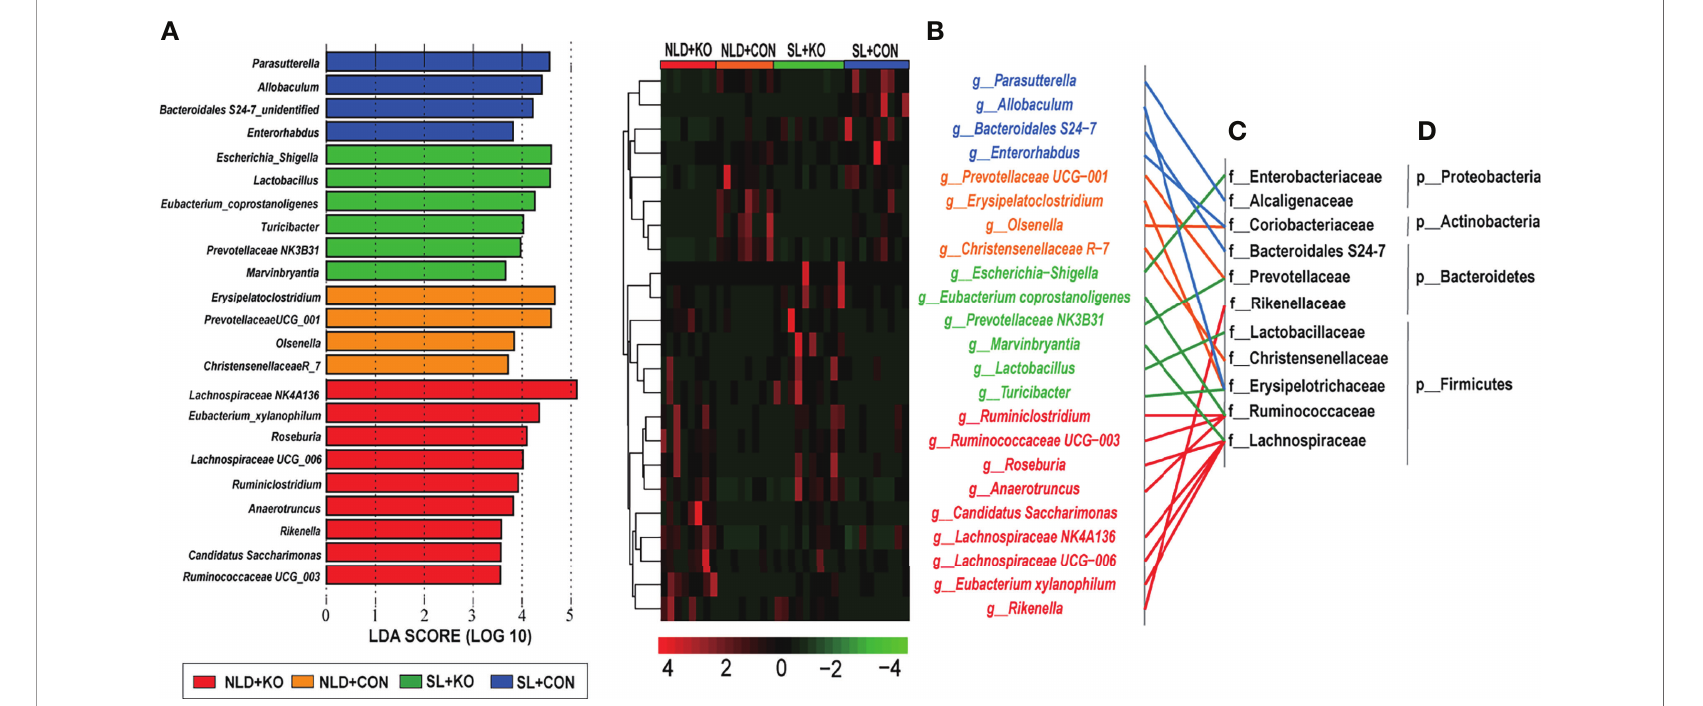
FIGURE 7 | LEfSe analysis and cluster heatmap of in intestinal differential microbial genus classi fi cations in KO and CON mice under NLD and SL. KO, Per2 gene knockout ( Period2 − / − ) mice; CON, wild-type ( Period2 +/+ ) mice; NLD, normal light – dark cycle treatment of 12 h of light and 12 h of darkness; SL, short-light treatment of 8 h of light and 16 h darkness. (A) Linear discriminant analysis (LDA) plus effect size (LEfSe) at bacterial genus levels in KO and CON mice under NLD and SL, only LDA score in over than 3.5 was marked. (B) Cluster heatmap of differential bacterial genus levels in KO and CON mice under NLD and SL. (C) Classi fi cation the differential bacterial genus in family levels. (D) Classi fi cation the differential bacterial genus in phylum levels. n = 6 per group for 16S rRNA